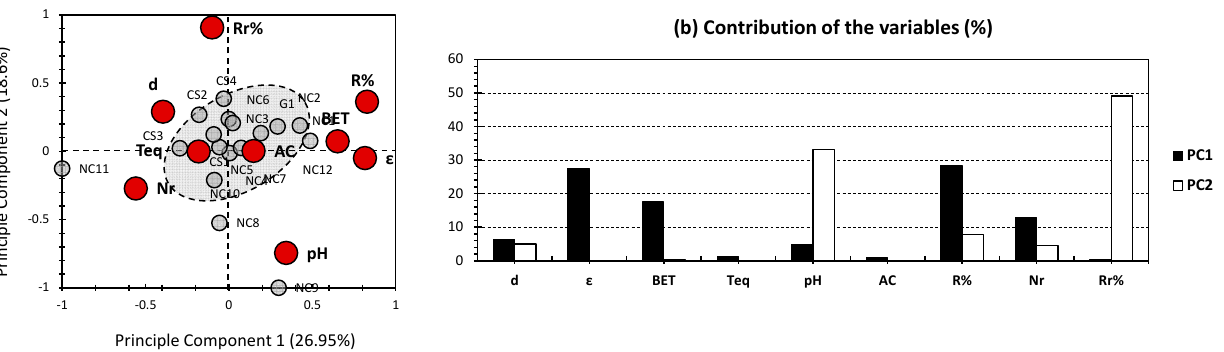
Figure 1. ( a ) PCA biplot for whole dataset. Gray bullets represent the individuals of the population (different investigated NC-, CS-, and G-based aerogels). Red bullets represent the variables (different employed physical/chemical and adsorption parameters). ( b ) Contribution of the variables.